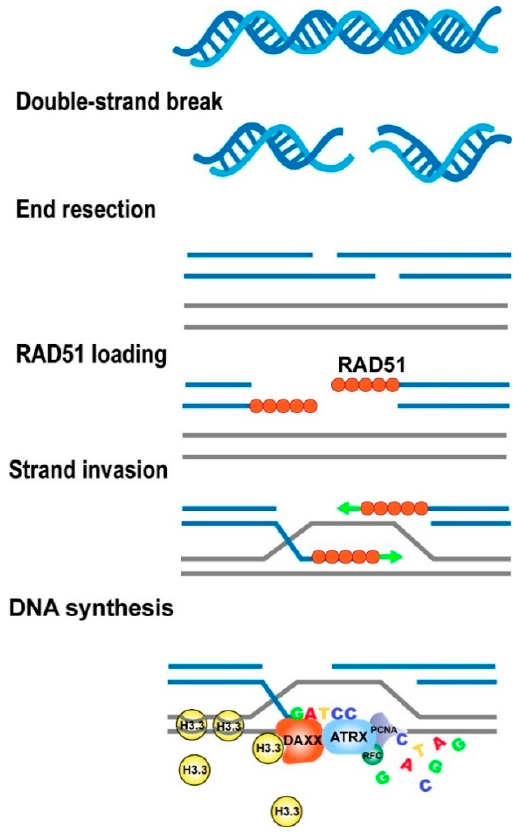
Figure 4. The ATRX-DAXX complex deposits the histone variant H3.3 during HR-mediated repair of DSBs. Abbreviations: HR, homologous recombination; DSBs, double-strand breaks.